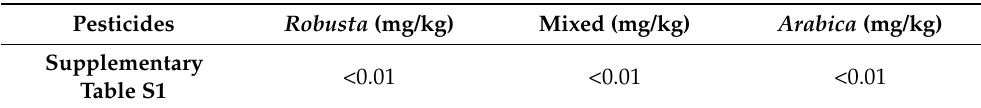
Table 5. Concentrations (mg/kg) of pesticides (showed in Supplementary Table S1) in three classes of samples ( n = 10) of coffee silverskin (CS).